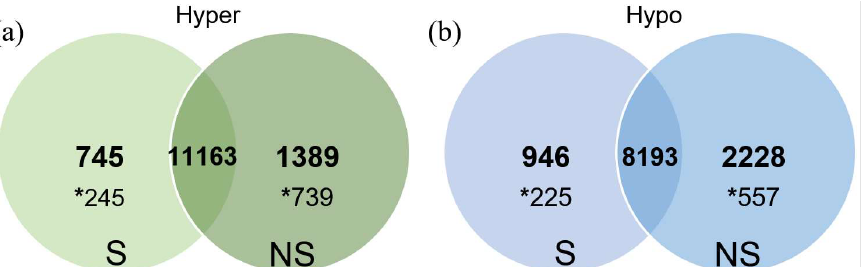
Figure 2. Venn diagram of hypermethylated ( a ) and hypomethylated ( b ) tiles from stimulated (S) and non-stimulated (NS) oocytes, exhibiting the number of exclusive tiles hyper ( a ) or hypo ( b ) methylated in each group and the common tiles hyper ( a ) or hypo ( b ) methylated between the groups. Within each group, the number preceded by an asterisk represents the number of tiles with a minimum of 10% absolute change in methylation percentage between groups ( p < 0.05).